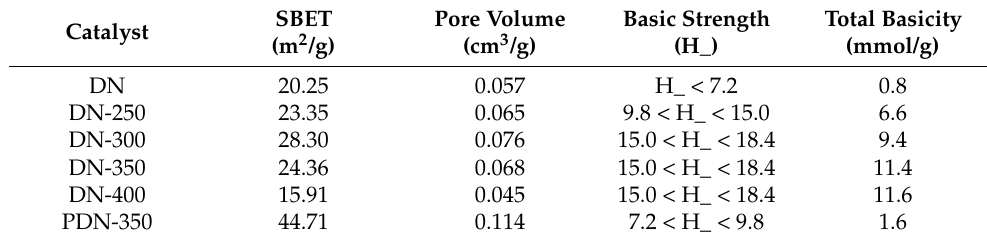
Table 1. Surface area results and basicity properties of catalysts.